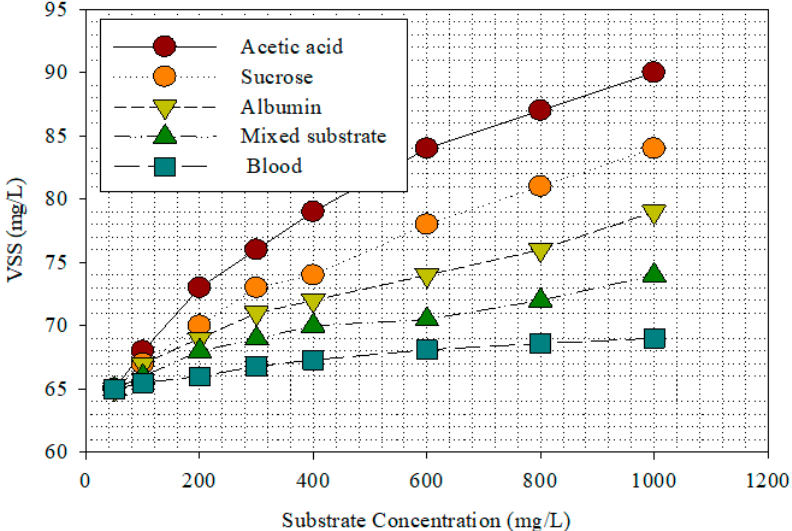
Processes 2021 , 9 , x FOR PEER REVIEW Figure 3. The dynamics of volatile solids at various substrate concentrations. Figure 3. The dynamics of volatile solids at various substrate concentrations.